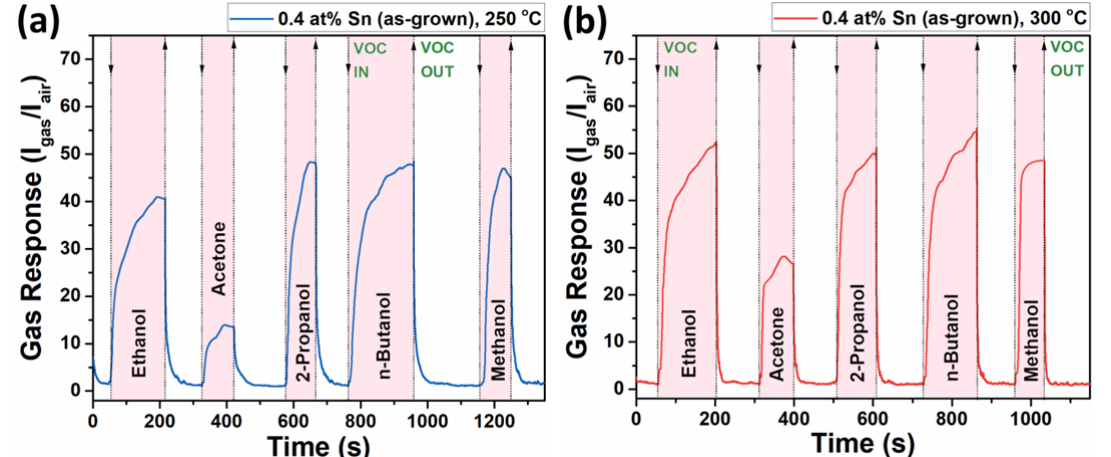
Figure 2. The dynamic gas response to 100 ppm of VOCs vapors for samples with 0.4 at% Sn: (a) at 250 ºC and (b) at 300